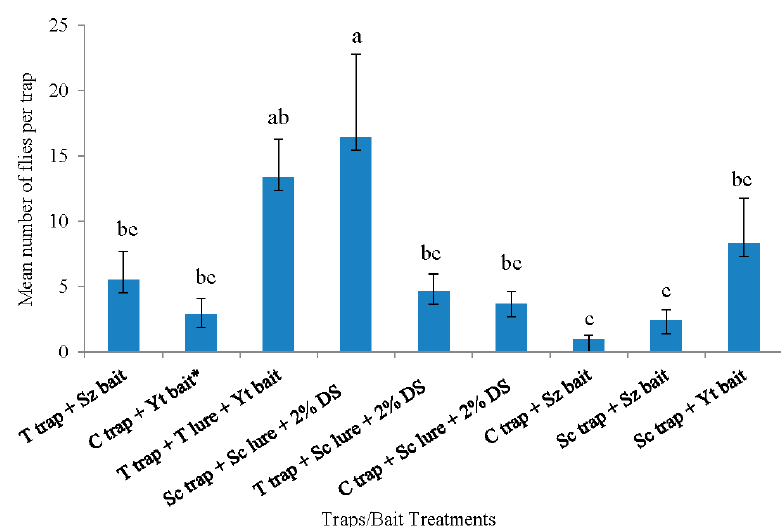
Figure 3. Pooled data of Drosophila suzukii adults captured (both sexes) with different trapping systems from all trapping periods in rabbiteye blueberry bushes from 26 May 2015 to 30 June 2015 in Citra, Florida, USA. Mean (± SE) number of adult flies with different letters are significantly different ( p ≤ 0.05; Tukey’s HSD (honestly significant difference) test from each other. T trap = Trécé trap, T lure = Trécé lure, Sz bait = Suzukii trap, C trap = Cup trap, Yt bait = Yeast bait, Sc trap = Scentry trap, Sc = Scentry lure, and 2% DS = 2% detergent solution. * Reference treatment.